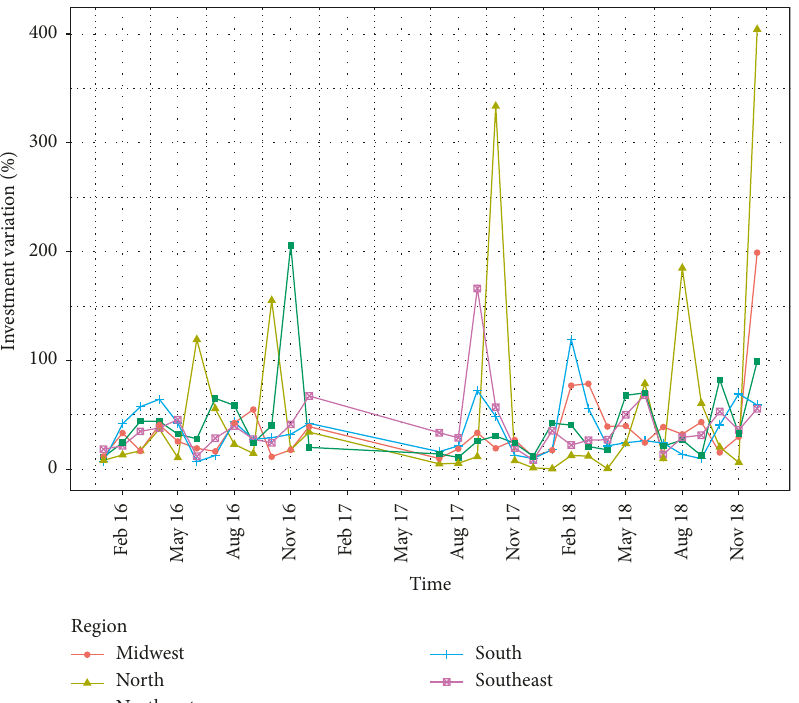
Figure 2: In this figure, we aggregate investment made by all investors by states to which they belong. As we can we have investors from all parts of Brazil in our